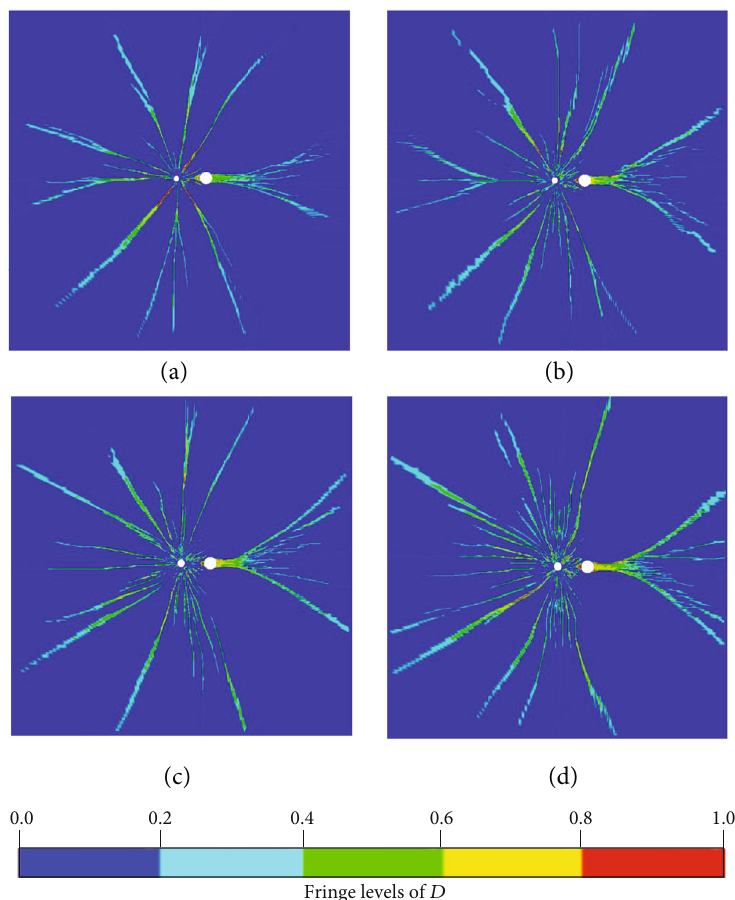
Figure 10: Tension damage of prime cut blasting under di ff erent diameters of the charge hole: (a) scheme 5, (b) scheme 11, (c) scheme 12, and (d) scheme